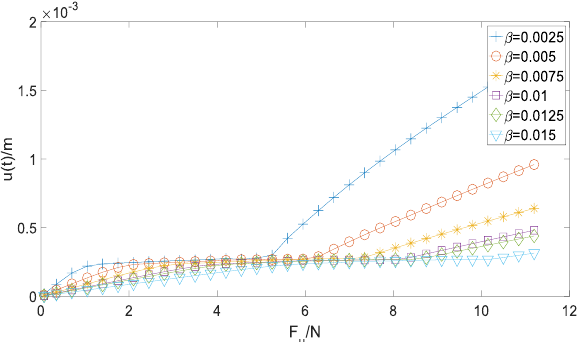
Figure 9. The optimal TET interval of the membrane NES with the specific impedance ratio 𝛽 in the range [0.0025, 0.015].